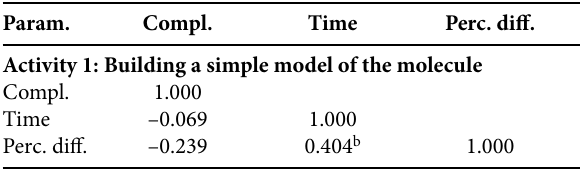
Table 3: Spearman correlations between completion level (Compl.), time spent (Time) and perceived difficulty of activities (Perc. diff.)